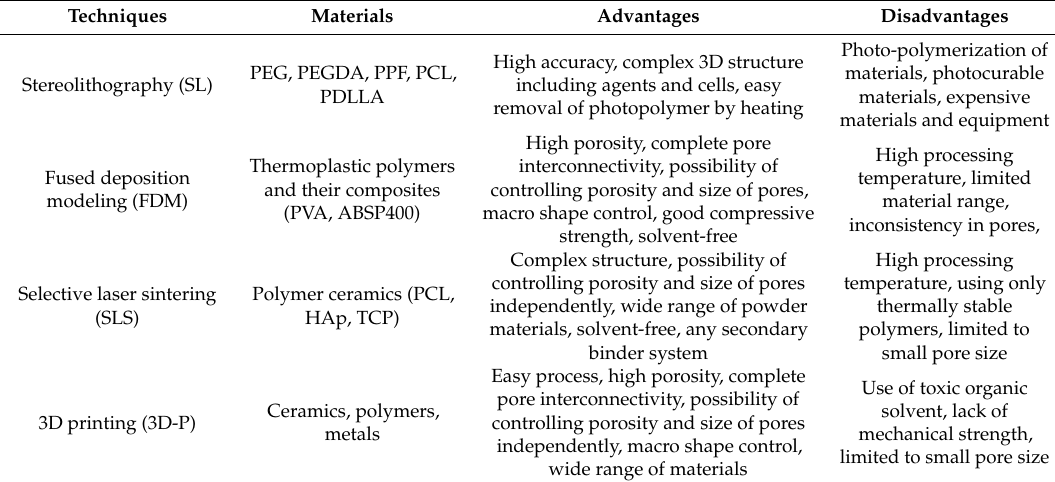
Table 4. Advantages and disadvantages of different SFFT